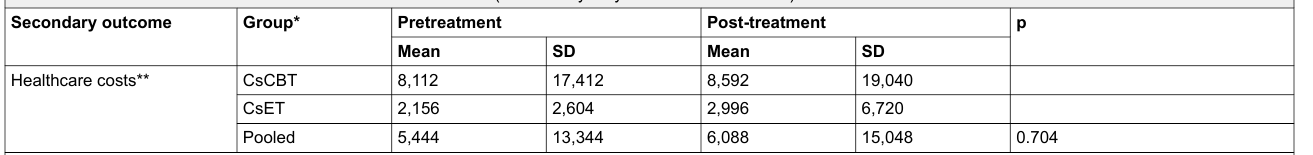
Table 5: Means and standard deviations of healthcare utilisation (estimated yearly costs in Swiss